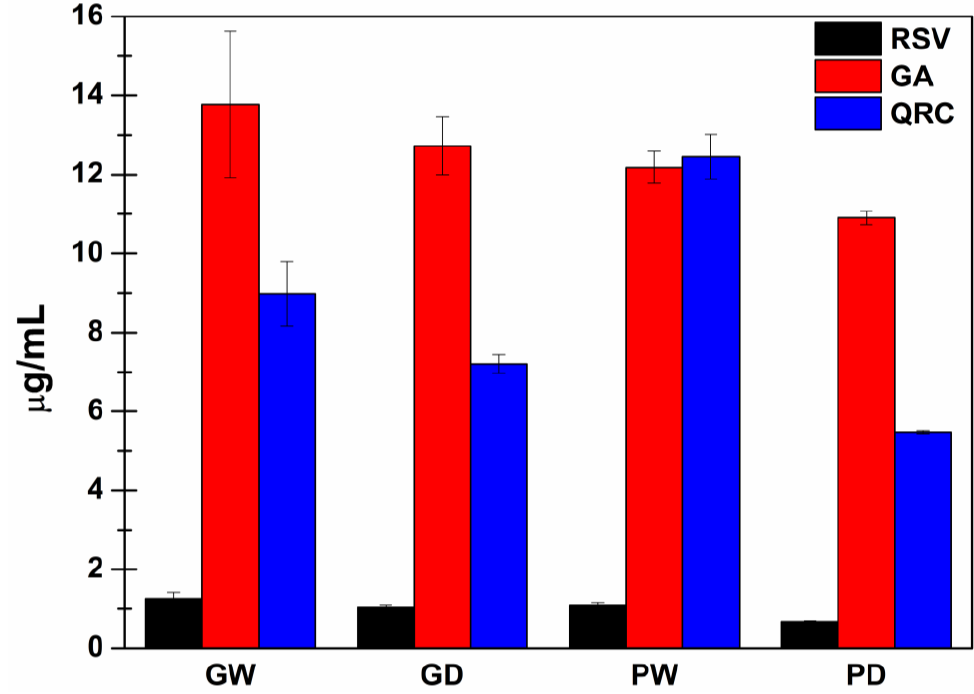
Figure 2. Concentration ( µ g mL − 1 ) ± SE of: Resveratrol (RSV—black), Gallic Acid (GA—red) and Quercetin (QRC—blue) detected in each extract by HPLC-DAD analyses ( n = 9). As observable from both the wet and the dry bentonite samples, high amounts of GA were generally extracted while only small quantities of RSV were recovered. Finally, the QRC concentration into the extracts resulted dependent by the starting presence of water: samples from the wet bentonite displayed a higher QRC concentration than the correspondent extracts from the freeze-dried bentonite (GW > GD and PW > PD). The observed differences were stronger for the PEG200-based samples. In any case, these changes are probably due to enhanced QRC solubility into the selected extraction solvents due to the action of the residual water as effective co-solvent